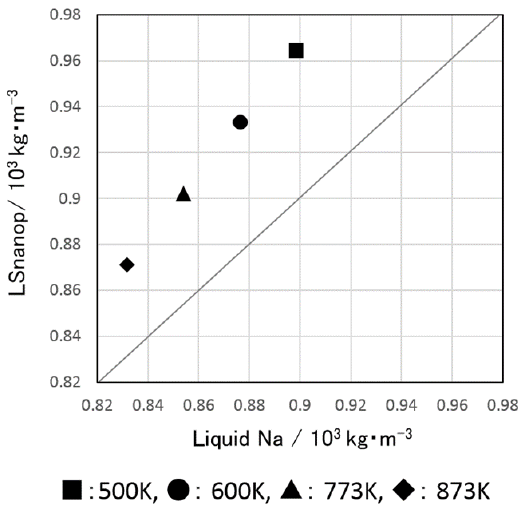
Figure 4. Comparison of the densities of LSnanop and liquid Na: The slanted line corresponds to the hypothetical case in which the densities of the LSnanop and liquid Na are the